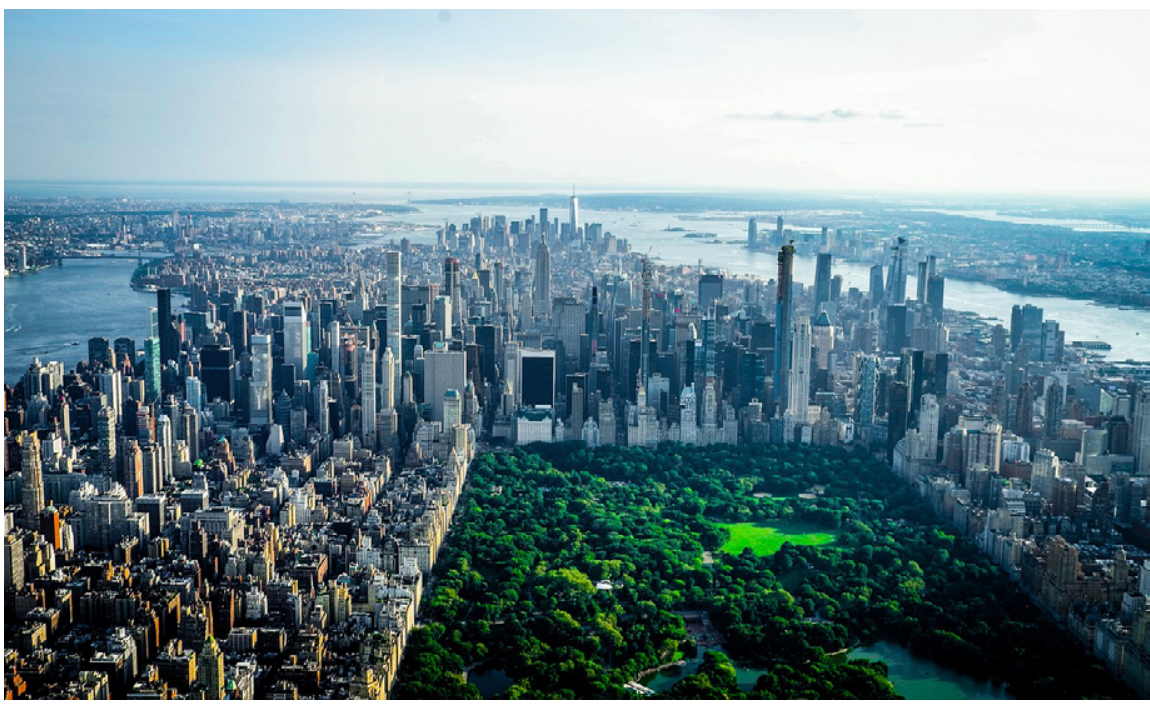
Central Park New York. Image Credit: © Creative commons [https://pixabay.com/